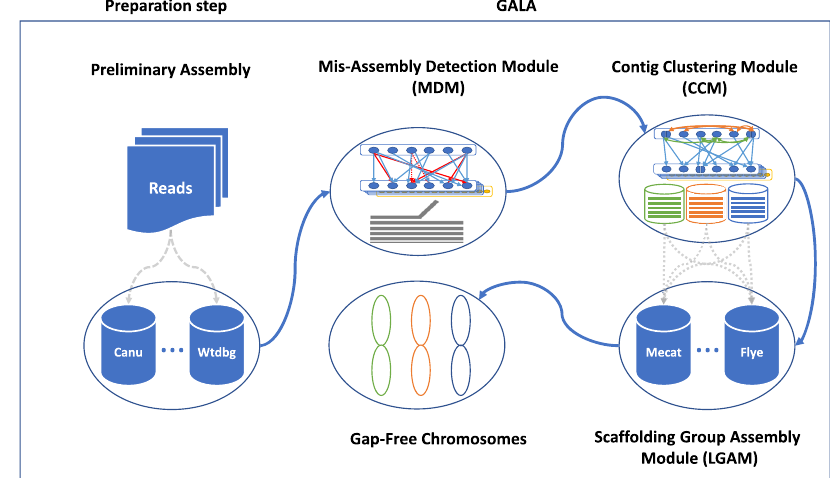
Fig.1|OverviewofGALA. Afterdenovoassemblingwithvarioustools,preliminary assemblies and raw reads are encoded into a multi-layer computer graph. Mis- assemblies are identi fi ed with MDM by browsing through the inter-layer